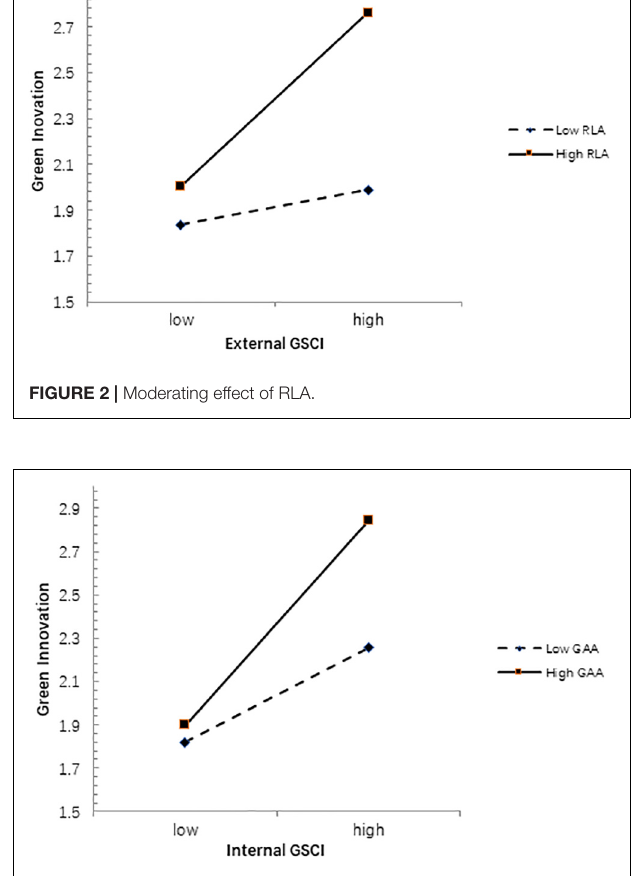
FIGURE 3 | Moderating effect of